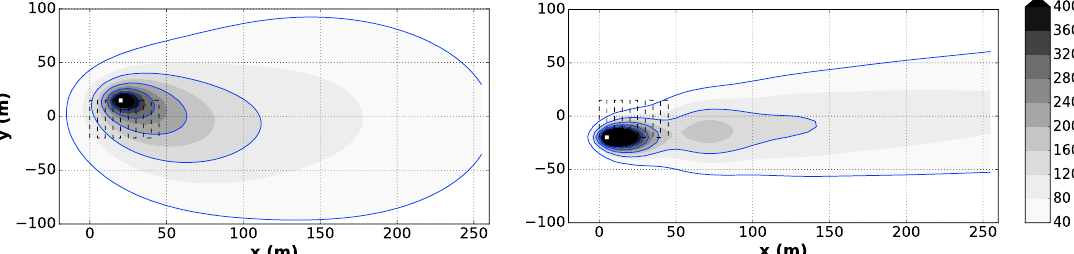
Figure 5. Analytical solution obtained by using the model proposed by Di Risio et al. [39]. Typical examples for hydraulic dredging ( left ) and mechanical dredging ( right ) are shown. Constant velocity along x-direction is considered. Dashed lines depict the dredge-head path during the works execution, square markers indicate the instantaneous location of the dredge-head. Color scale refers to the suspended sediment concentration (SSC) (g/m 3